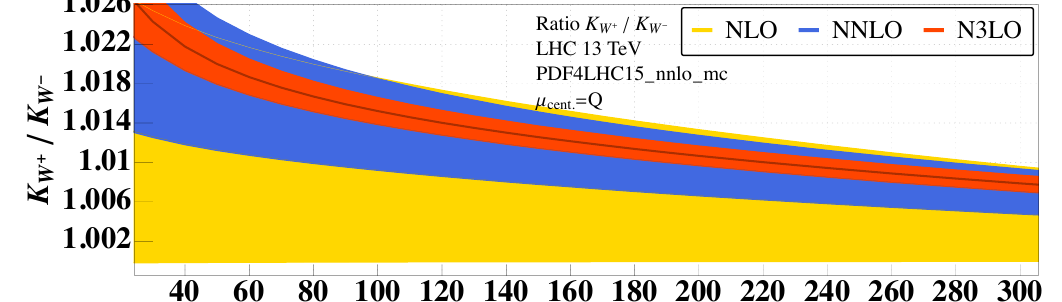
Figure 8. Ratio of the K-factors for W + and W − production as a function of Q 2 at different orders in perturbation theory.